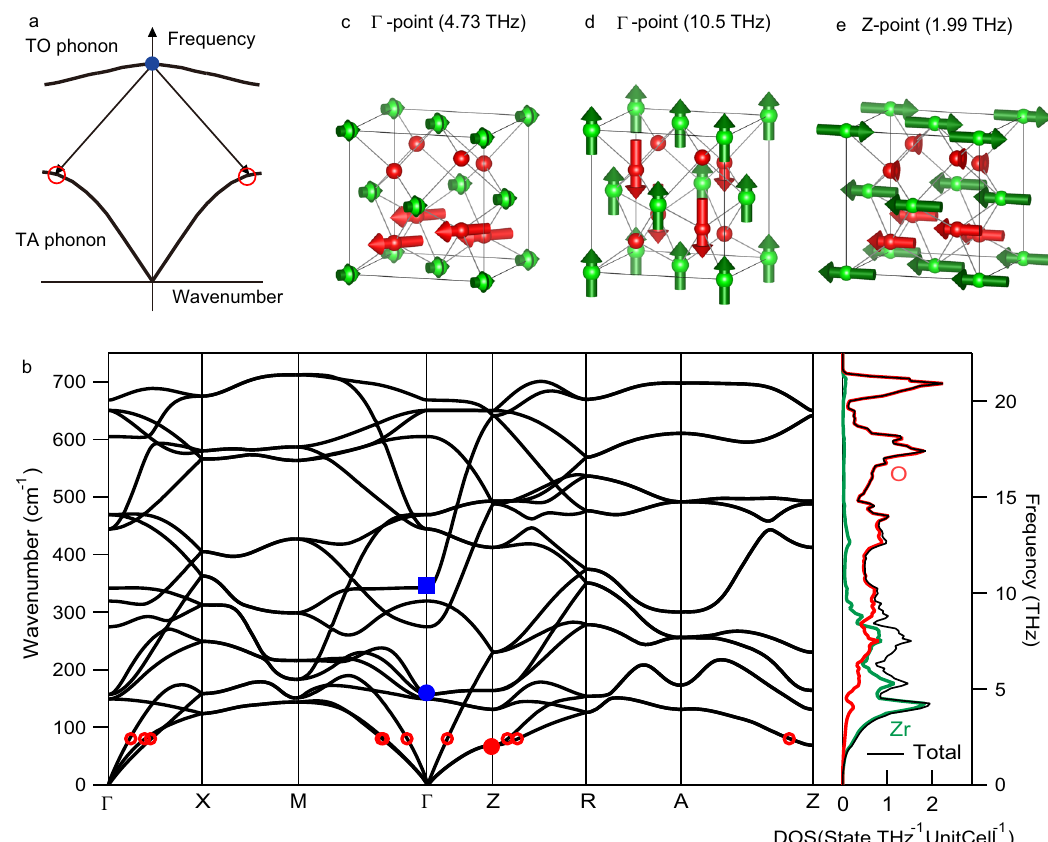
Fig. 6 The phonon modes of t-ZrO 2 that are related to the martensitic transformation. a The schematic of the Klemens process. b The phonon branches are shown along high-symmetry directions in the Brillouin zone. The open red circles show the phonon modes at half of the frequency of the infrared-active TO phonon mode shown by the closed blue circle in ( b ). In the right panel, the total phonon density of states in t-ZrO 2 is indicated by the black line. The partial phonon density of states (DOS) of the Zr and O atoms are indicted by the green and red lines, respectively. Ion displacements induced by infrared- active TO phonon modes at the Γ -point ( c ); 4.73 THz and ( d ); 10.5 THz), and those induced by the lowest phonon mode at the Z-point ( e ), 1.99 THz). These three phonons are shown by the closed blue circle, the closed blue square, and the closed red circle in ( b ),